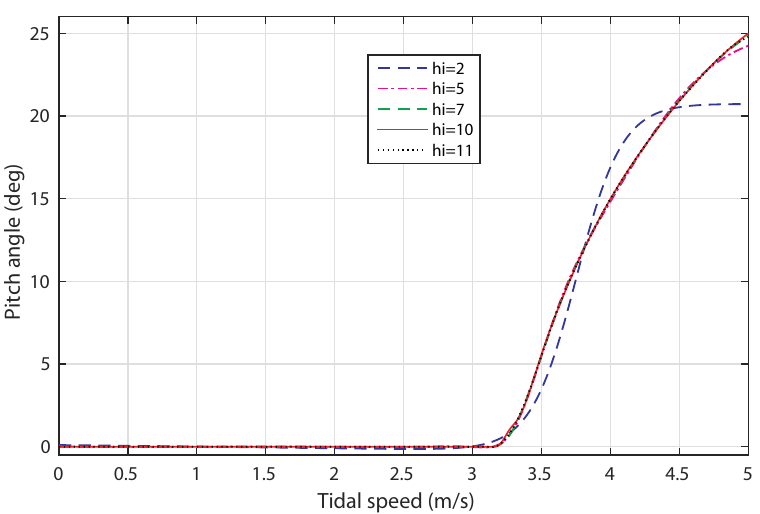
Figure 8. Response of the ANN-based MPPT control.